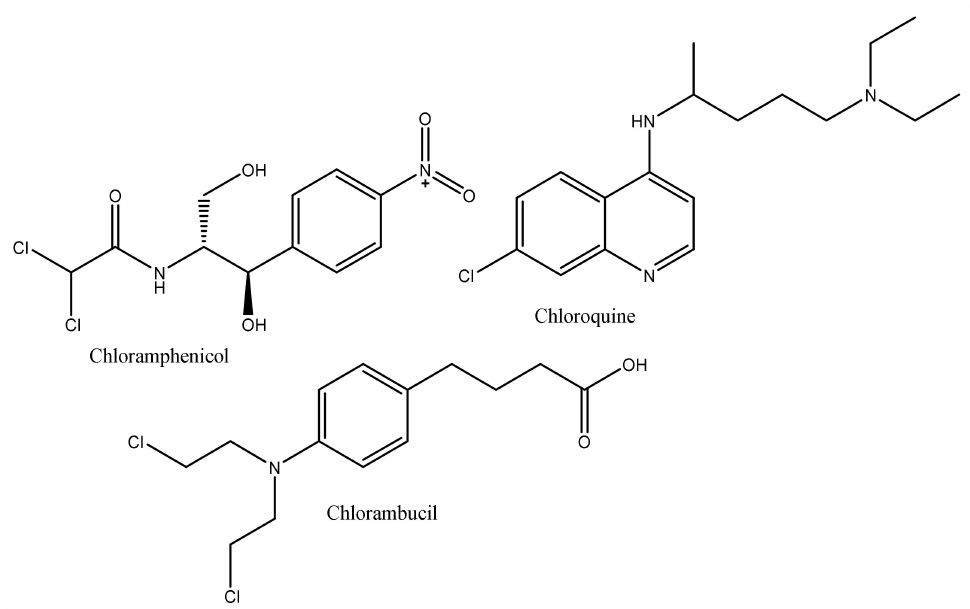
Figure 2. Structural formulas of chloramphenicol, chloroquine, and